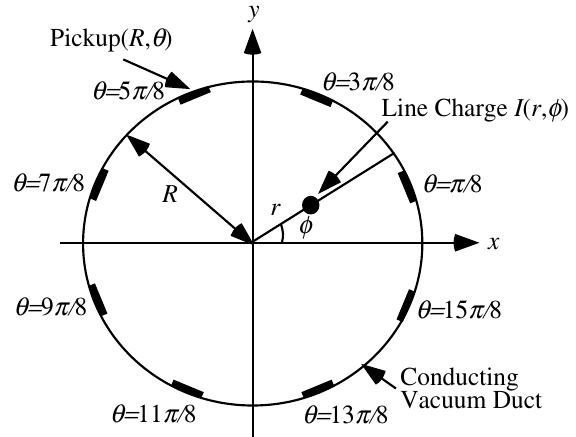
FIG. 1. Polar coordinates of a line charge and eight pickups defined in a conducting